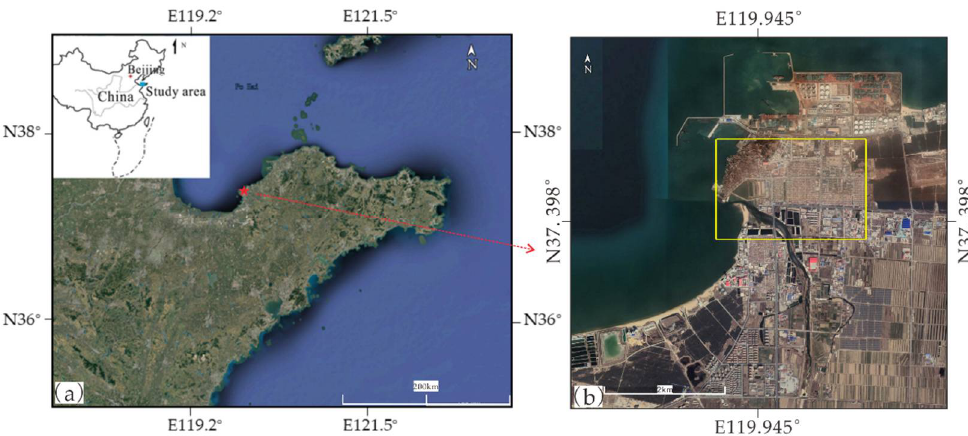
Figure 1. ( a ) The Google Earth view localizes the Shandong Province to which the mining area belongs. ( b ) Specific location of the study area. (The main mining area is outlined by a solid, yellow, rectangular line.)